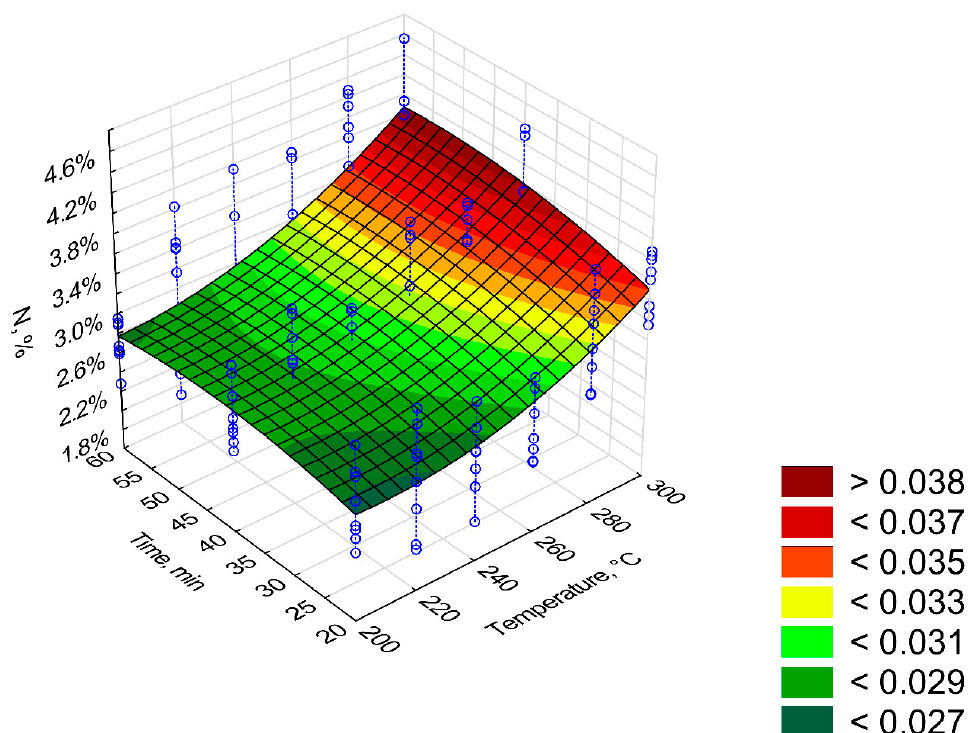
Figure 13. Visualization of 3D model of N content of torrefied pruned biomass. Table 11. Statistical evaluation of N content model of torrefied pruned biomass.